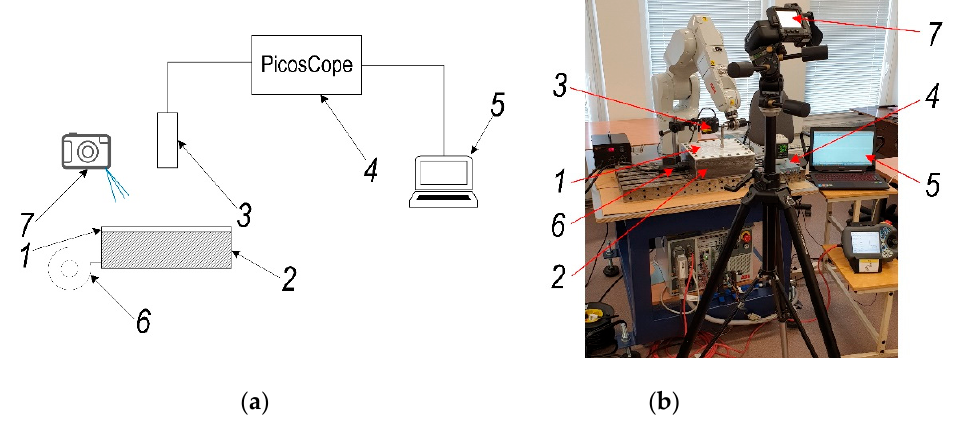
Figure 7. Experimental set-up for polymer sheet forming parameters validation: ( a ) scheme; ( b ) set-up